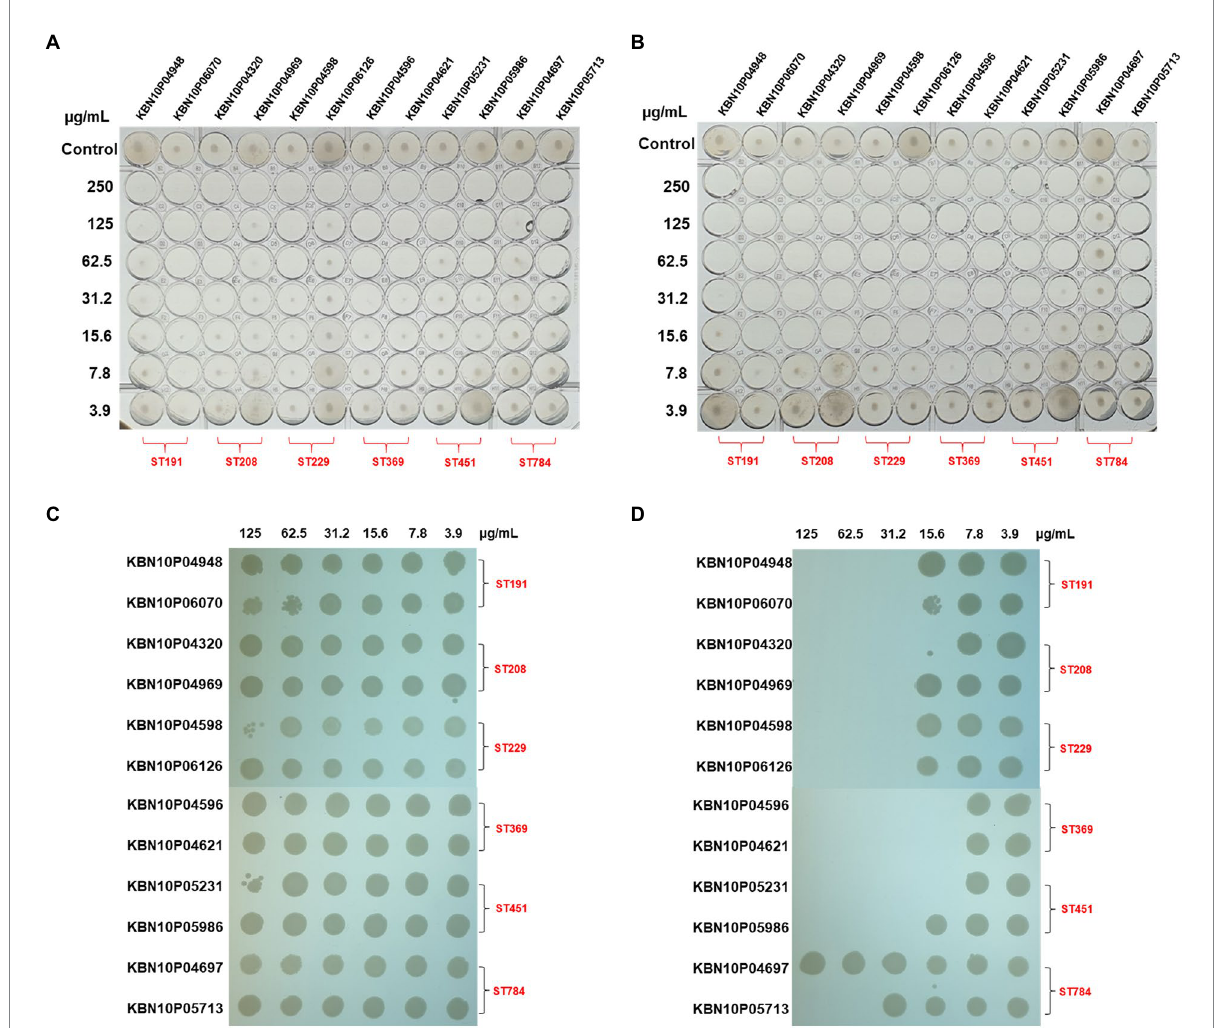
FIGURE 2 Antibacterial activity of AbEndolysin and eAbEndolysin. (A,B) Antimicrobial activity of AbEndolysin (A) and eAbEndolysin (B) against multidrug- resistant (MDR) Acinetobacter baumannii clinical isolates (ST191, ST208, ST229, ST369, ST451, and ST784) were measured by minimum inhibitory concentration (MIC). AbEndolysin was serially diluted two-fold from the highest concentration (250 μ g/ml) to confirm the inhibitory concentration. Fresh bacterial culture in Mueller–Hinton broth (MHB) was used as control. (C,D) Minimum bactericidal concentration (MBC) of AbEndolysin (C) and eAbEndolysin (D) against the same set of